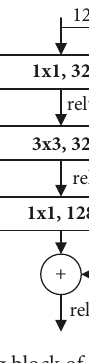
Figure 1: Basic building block of Resnet-50 1 by 2